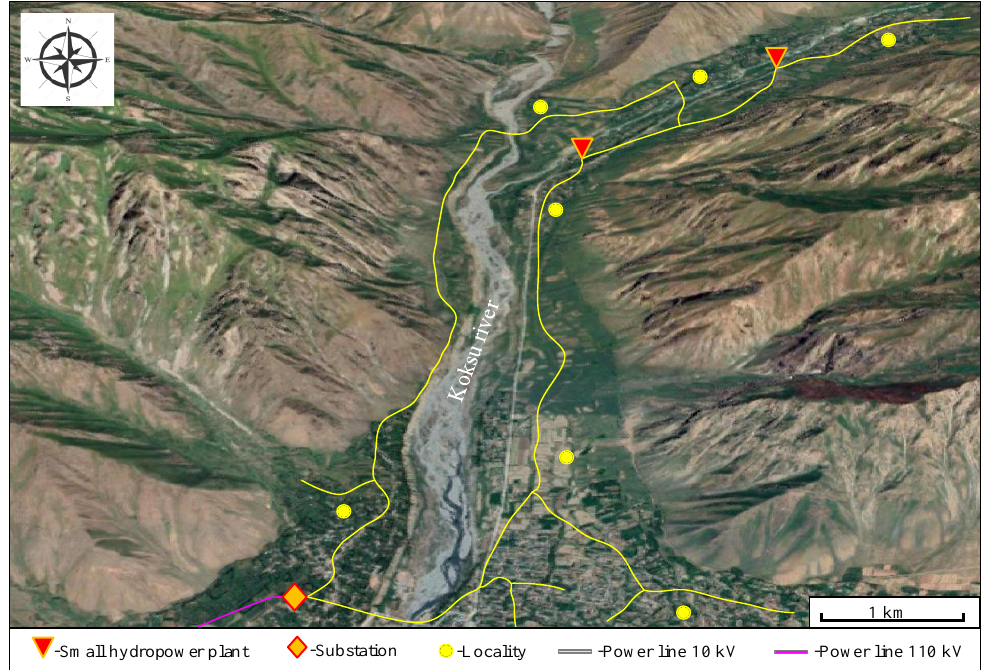
Figure 3. The geographical map of the grid under study of the Lahsh district in Tajikistan.